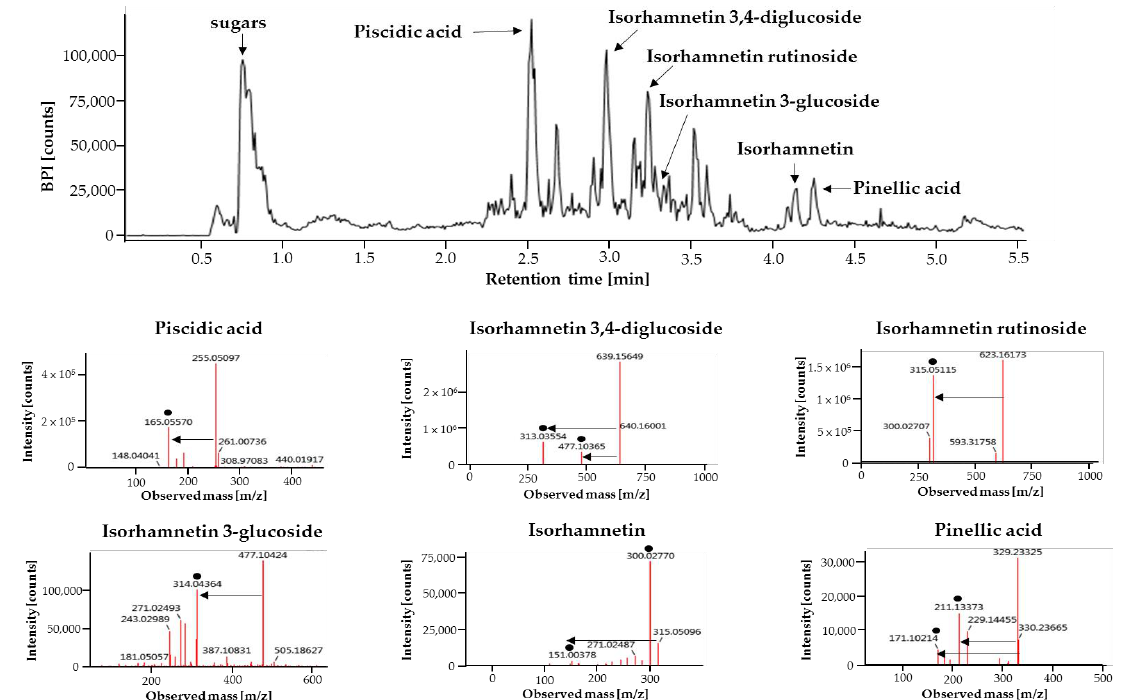
Figure 1. The liquid chromatogram of Opuntia humifusa fruit water extract (OHE) and tandem mass spectrometry (MS/MS) data of major phytochemicals. Phytochemicals in the OHE were analyzed using UPLC-Q-TOF MS equipped with an Acquity UPLC BEH C18 column (2.1 mm × 100 mm, 1.7 µm) and negative mode ESI. Major phytochemicals were identified by using the UNIFI scientific information system with various LC/MS online databases. Solid spots indicated mass fragments of major phytochemicals.